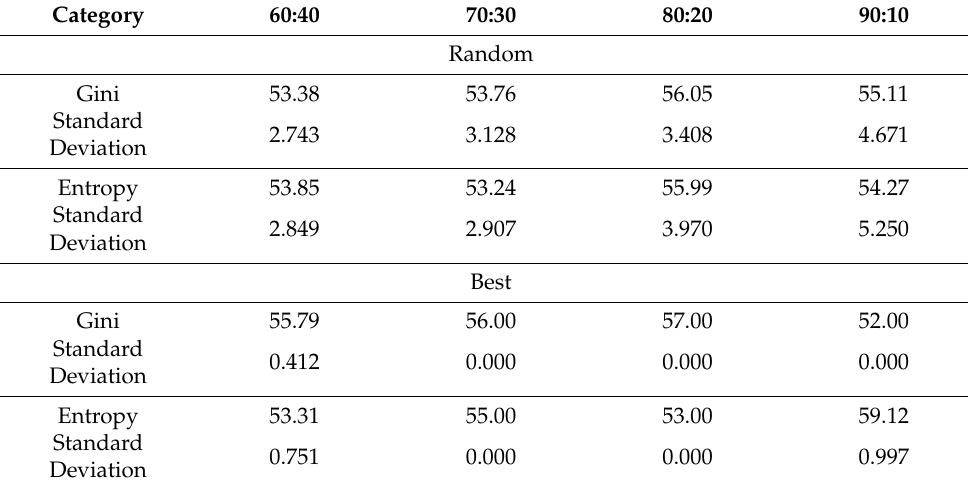
Table 4. Decision Tree Summarized Results.